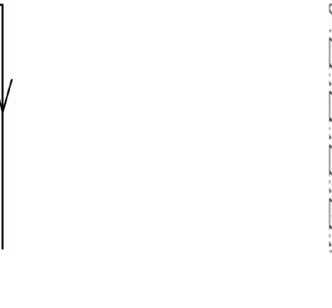
Figure 2. Nozzle scan patterns for the test pieces fabricated with the FFF 3D printer. ( a ) Parallel, P.; ( b ) Cross-hatched at opposing diagonal angles, C.